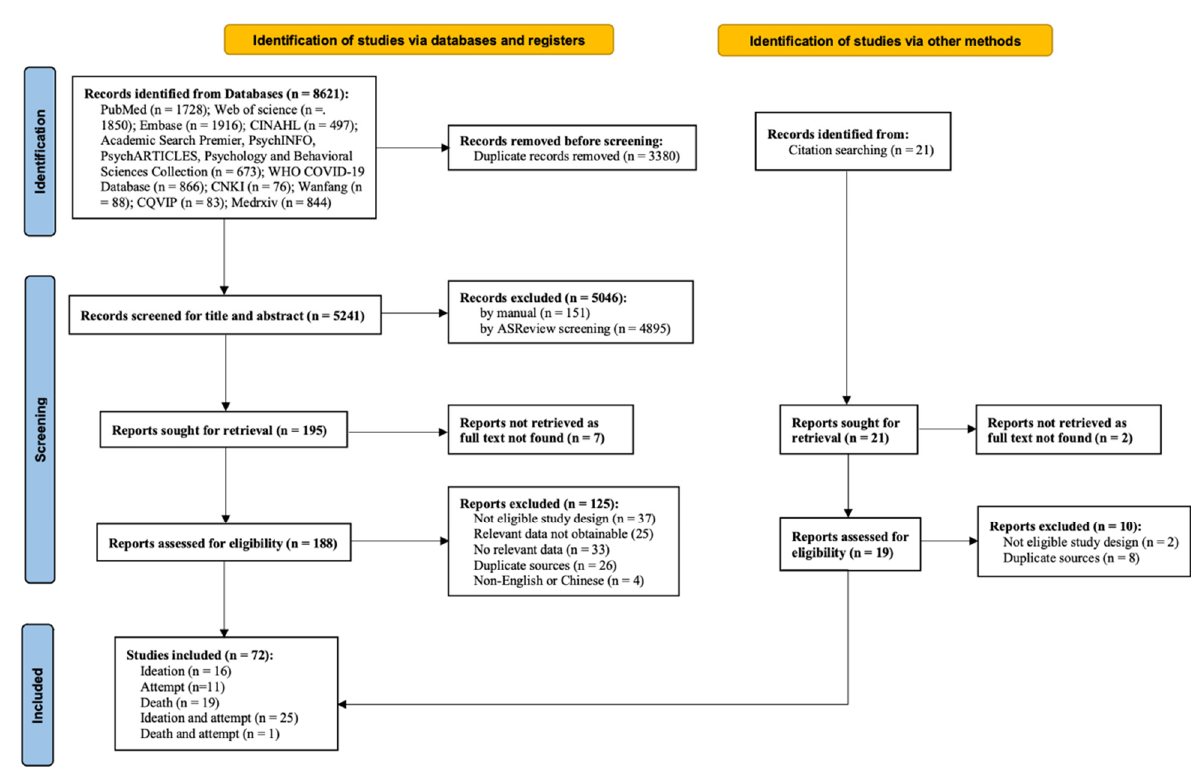
Figure 1. PRISMA flow chart.